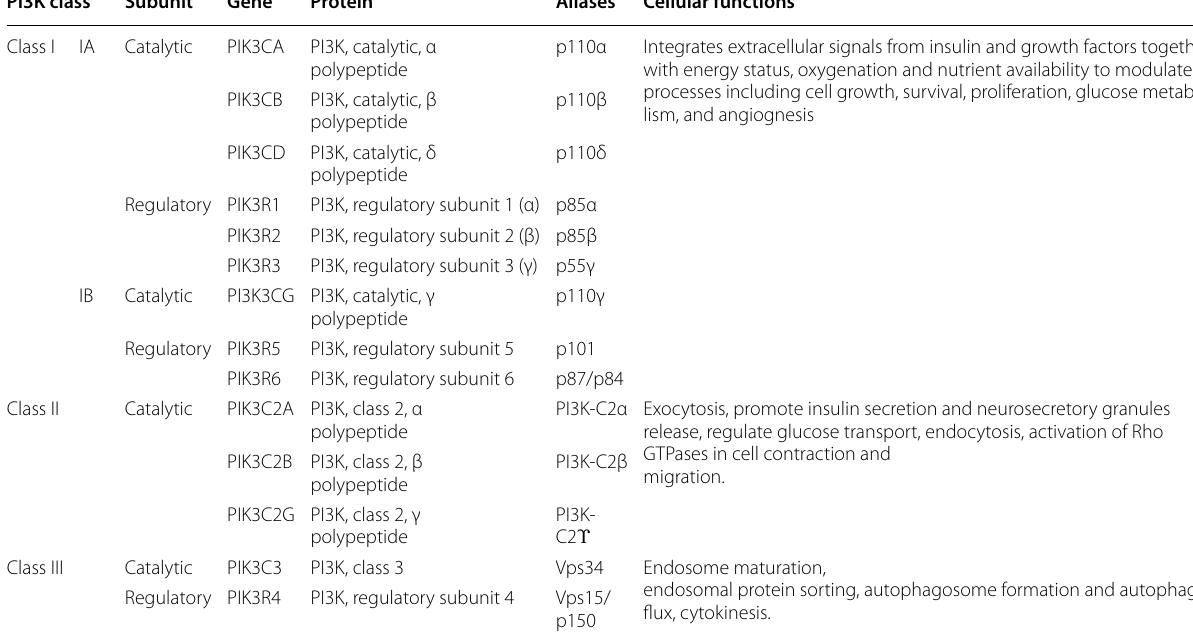
Table 1 Different classes of PI3K enzymes and their